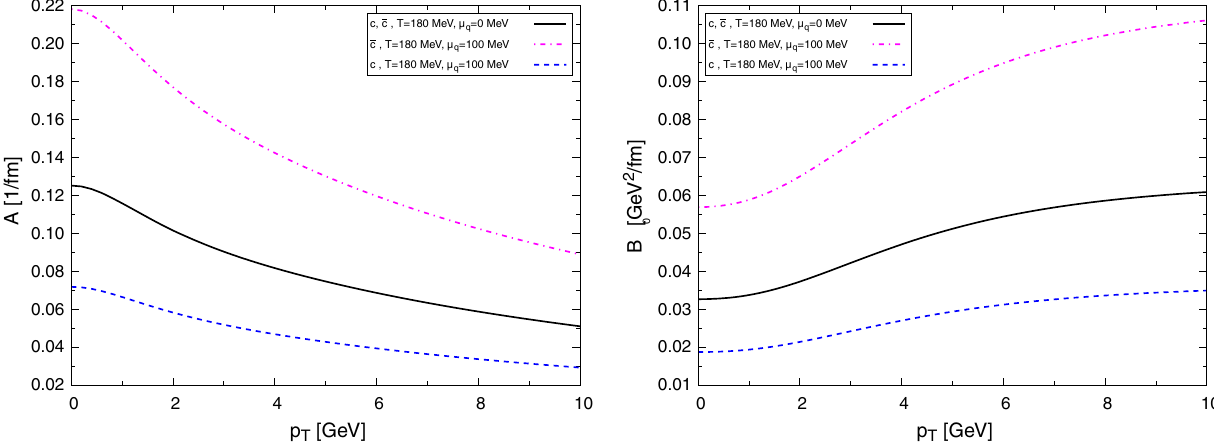
Fig. 2 Drag (left) and diffusion (right) coefficients in the resonance model for charm quarks at different temperatures taking into account also a fugacity factor e ( − μ/ T ) for charm and e (μ/ T ) for anti-charm